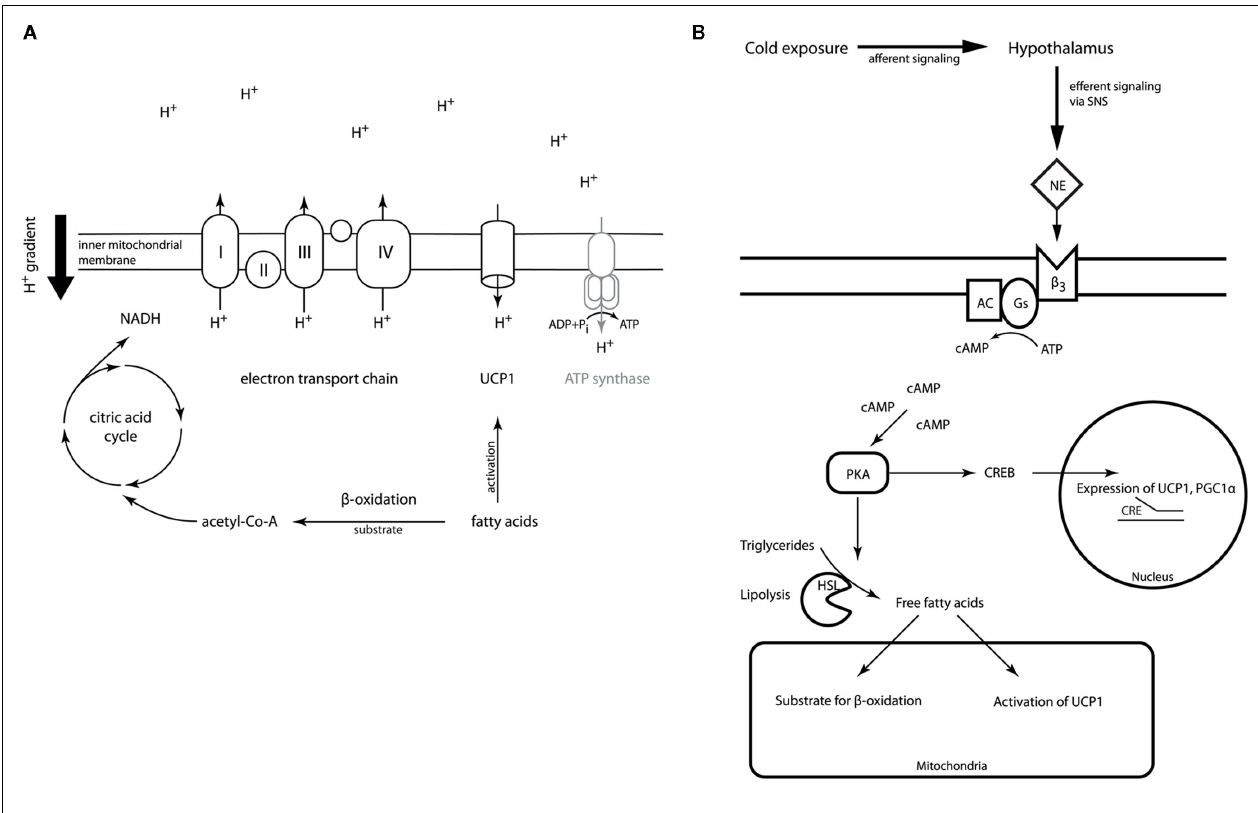
receptors are integrated in the hypothalamus.The efferent signal is transmitted via the sympathetic nervous system (SNS) and norepinephrine (NE) acting on the β 3 -adrenoreceptor located on the brown adipocyte surface, which is coupled to the cAMP second messenger pathway. Phosphorylation of hormone sensitive lipase and perilipin activates lipolysis.The resulting free fatty acids provide the fuel for thermogenesis and activate UCP1 allosterically. Additionally, transcription of UCP1 and PGC-1 α is activated via the CREB/CRE